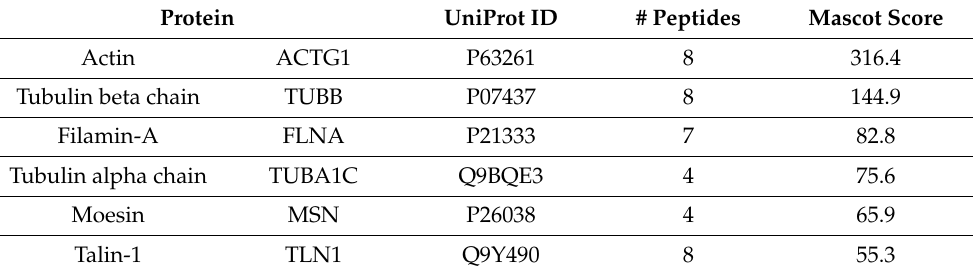
Table 2. Cystoskeleton proteins identified by MS analysis using the Proteome Discoverer software. Corresponding peptides were obtained after biochemical treatments of the captured cytoplasmic proteins from MDA-MB-231 breast cancer cells on AB186-hybridized SPR chip. # Peptides: number of different peptides corresponding to a unique protein. Mascot Score: statistical score based on the probability that the peptides from the sample match those in the selected protein database.